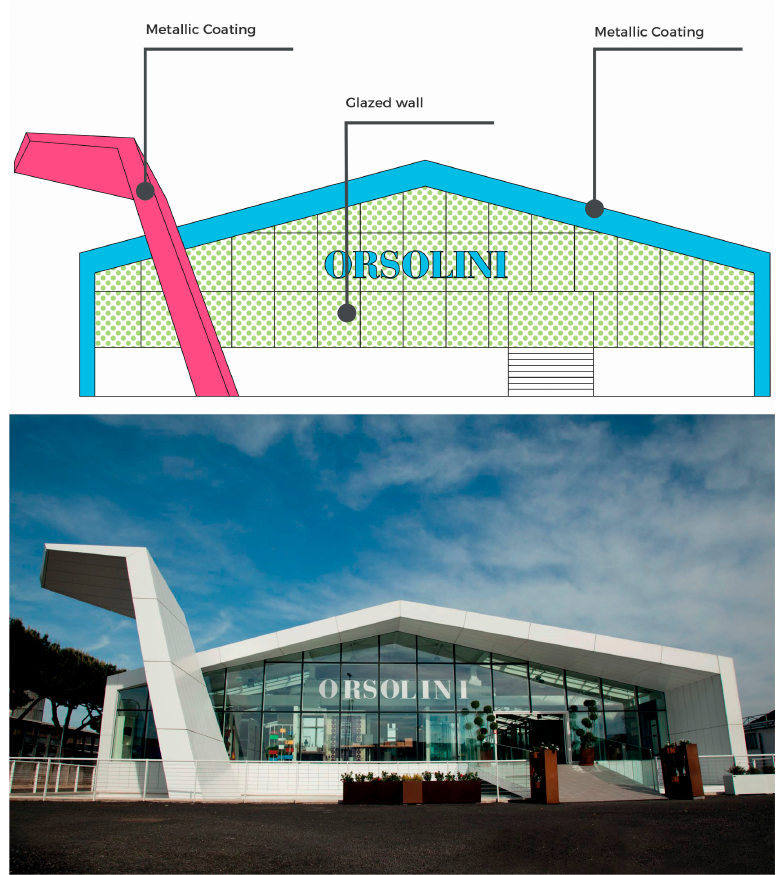
Figure 6. Front façade on GRA outer carriageway (image by Rosario Di